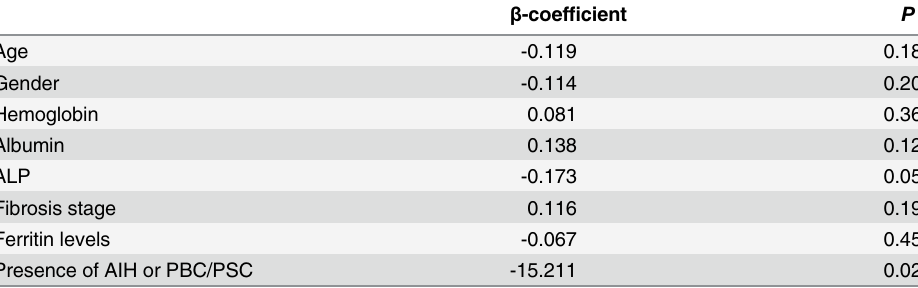
β -coef fi cient P